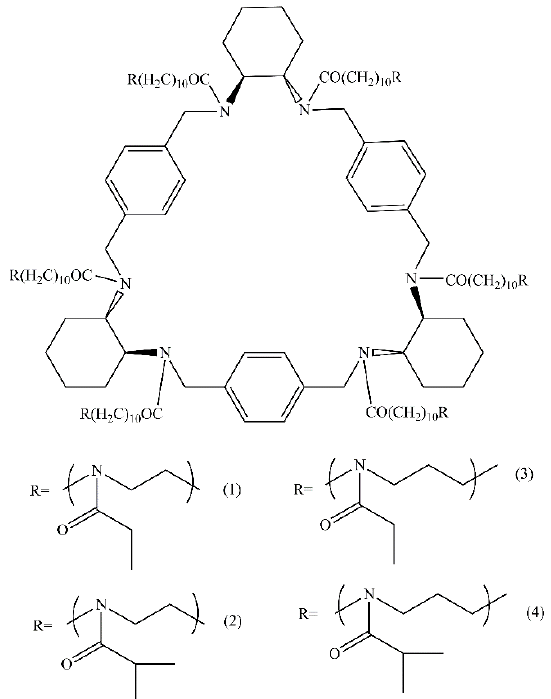
Figure 1. Structure of star-shaped CPh6-PEtOx ( 1 ), CPh6-PiPrOx ( 2 ), CPh6-PEtOz ( 3 ), and CPh6- PiPrOz ( 4 ).